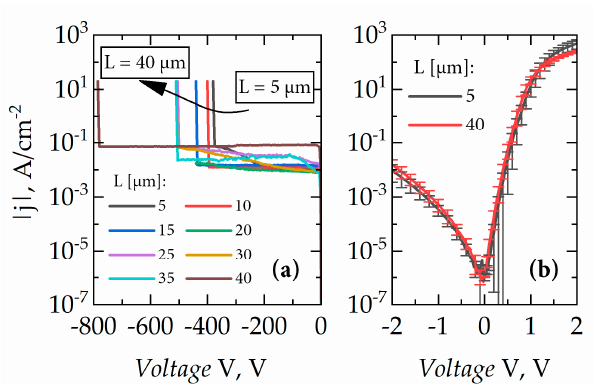
Figure 6. ( a ) Reverse current-voltage characteristics of SBDs and ( b ) current-voltage characteristics of SBDs with L = 5 and 40 µ m at low voltages.